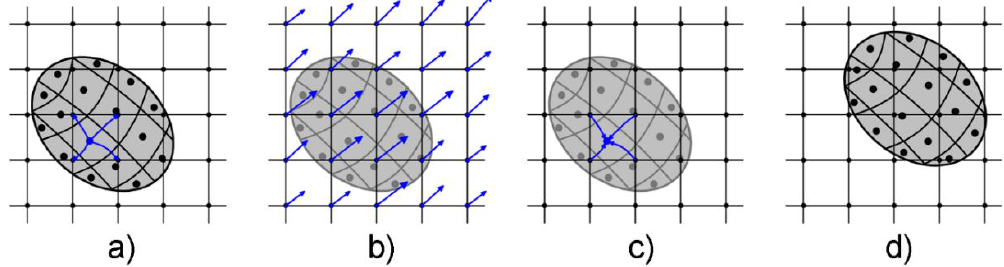
Figure 3. Computational scheme of MPM: ( a ) Map information from material points to grid nodes; ( b ) Solution of the governing equations at the nodes; ( c ) Update of the material point information; ( d ) Update of the material point position.